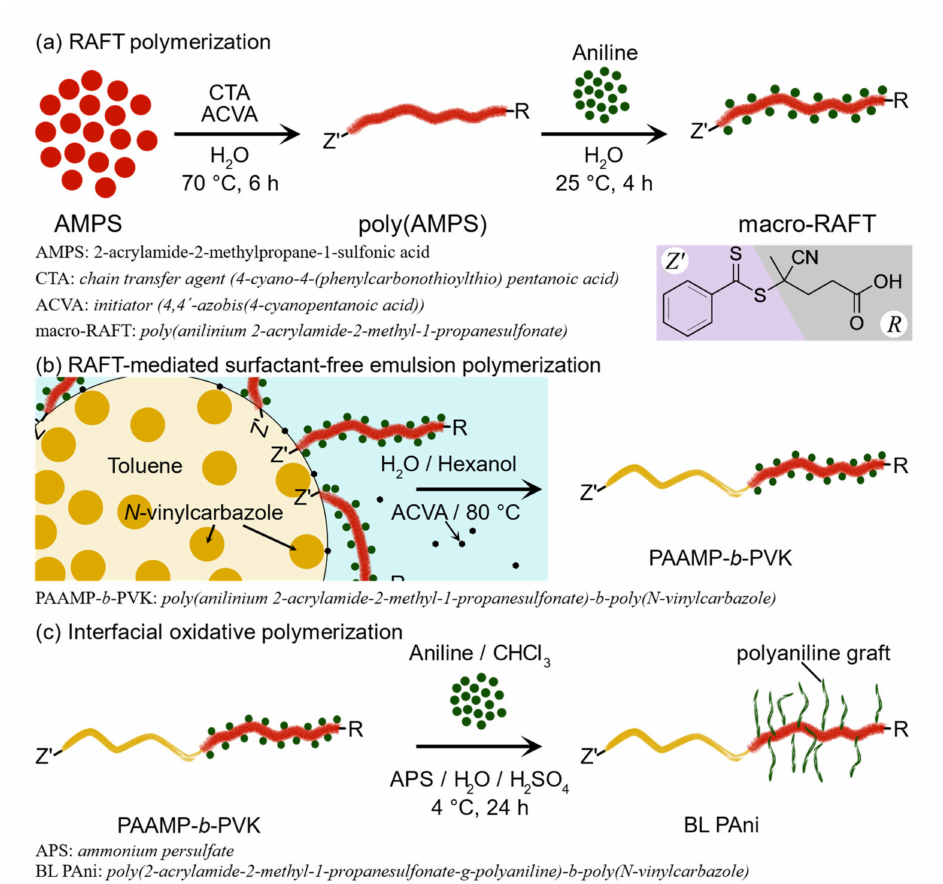
Figure 1. Sequence of polymerizations for the synthesis of brush-like polyaniline (BL PAni). ( a ) RAFT polymerization; ( b ) RAFT-mediated surfactant-free emulsion polymerization; ( c ) Inter- facial oxidative polymerization. Table 1. Formulations of the poly(anilinium 2-acrylamide-2-methyl-1-propanesulfonate)- b -poly( N